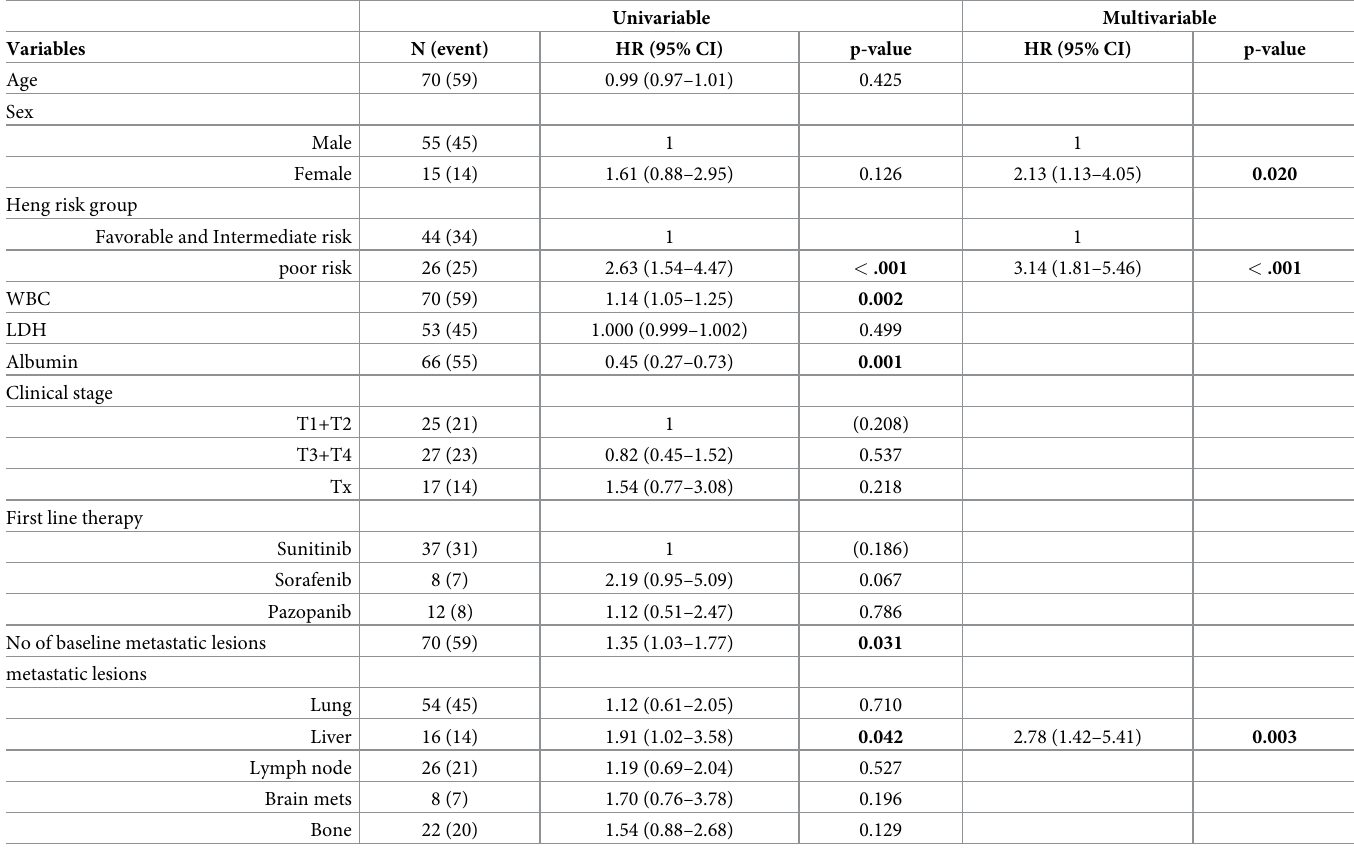
Table 3. Cox regression analysis of the prognostic factors for overall